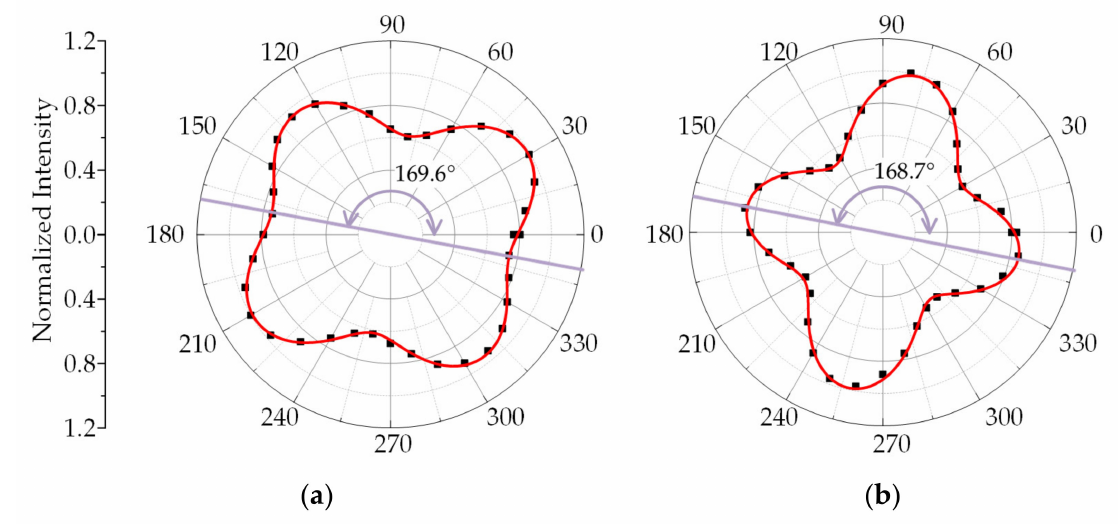
Figure 7. Comparison of the experimental results (black solid points) and theoretical results (red solid line) under the vertical backscattering configuration in the ( a ) HH case and in the ( b ) HV